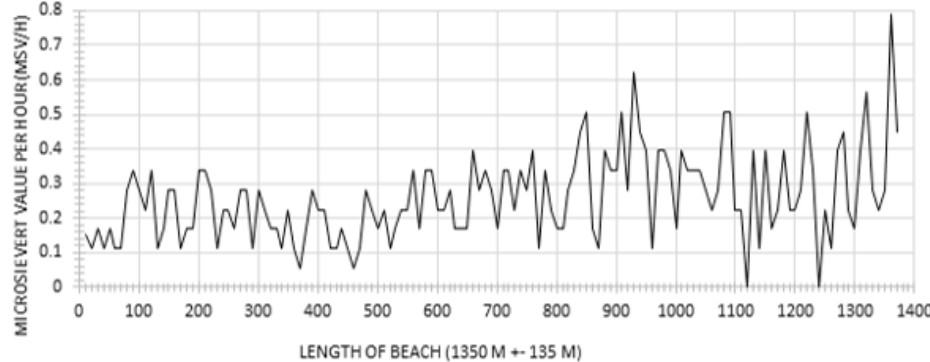
Figure 1. Measurement of radiation in microsievert per hour ( µ Sv.h-1) on October 1, 2016 at Santa Mônica beach, Guarapari, ES. The measured stretch corresponds to 1350 meters, adopting 10% of uncertainty given by the computer cycle to more or less corresponding to 135 meters of uncertainty. Table 1. Beach classification according to the maximum annual dose that a human being can receive in mSv.y-1. Beach